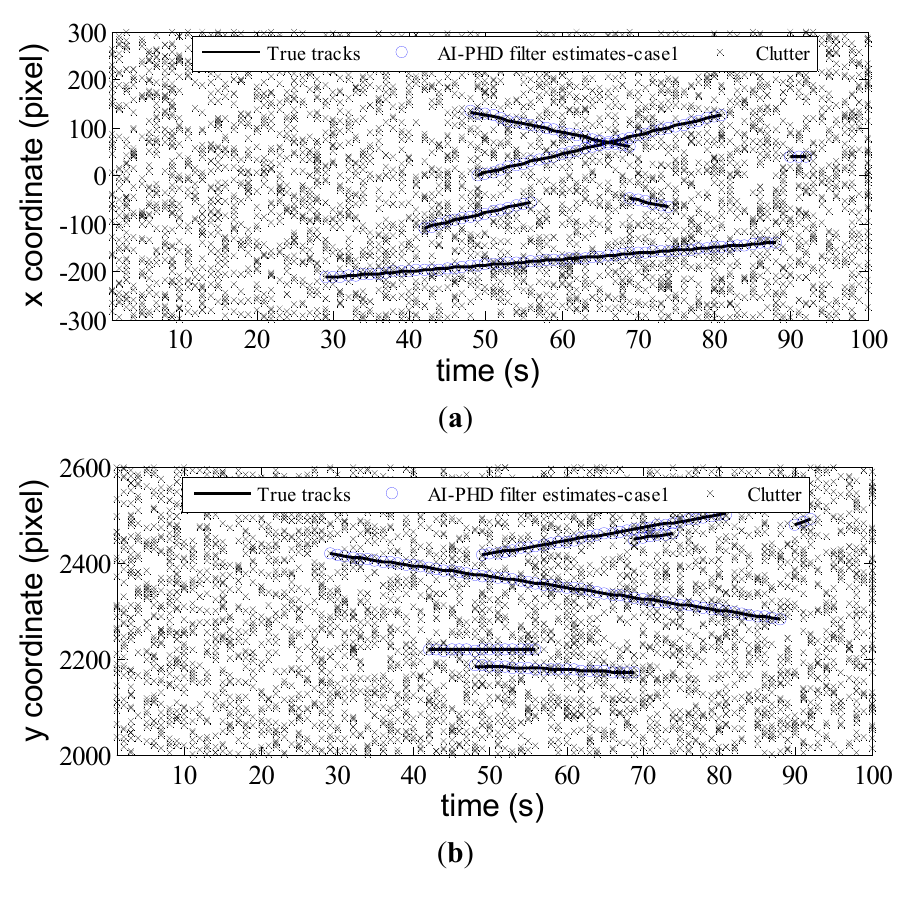
Figure 2. Filter estimates with known SNR.